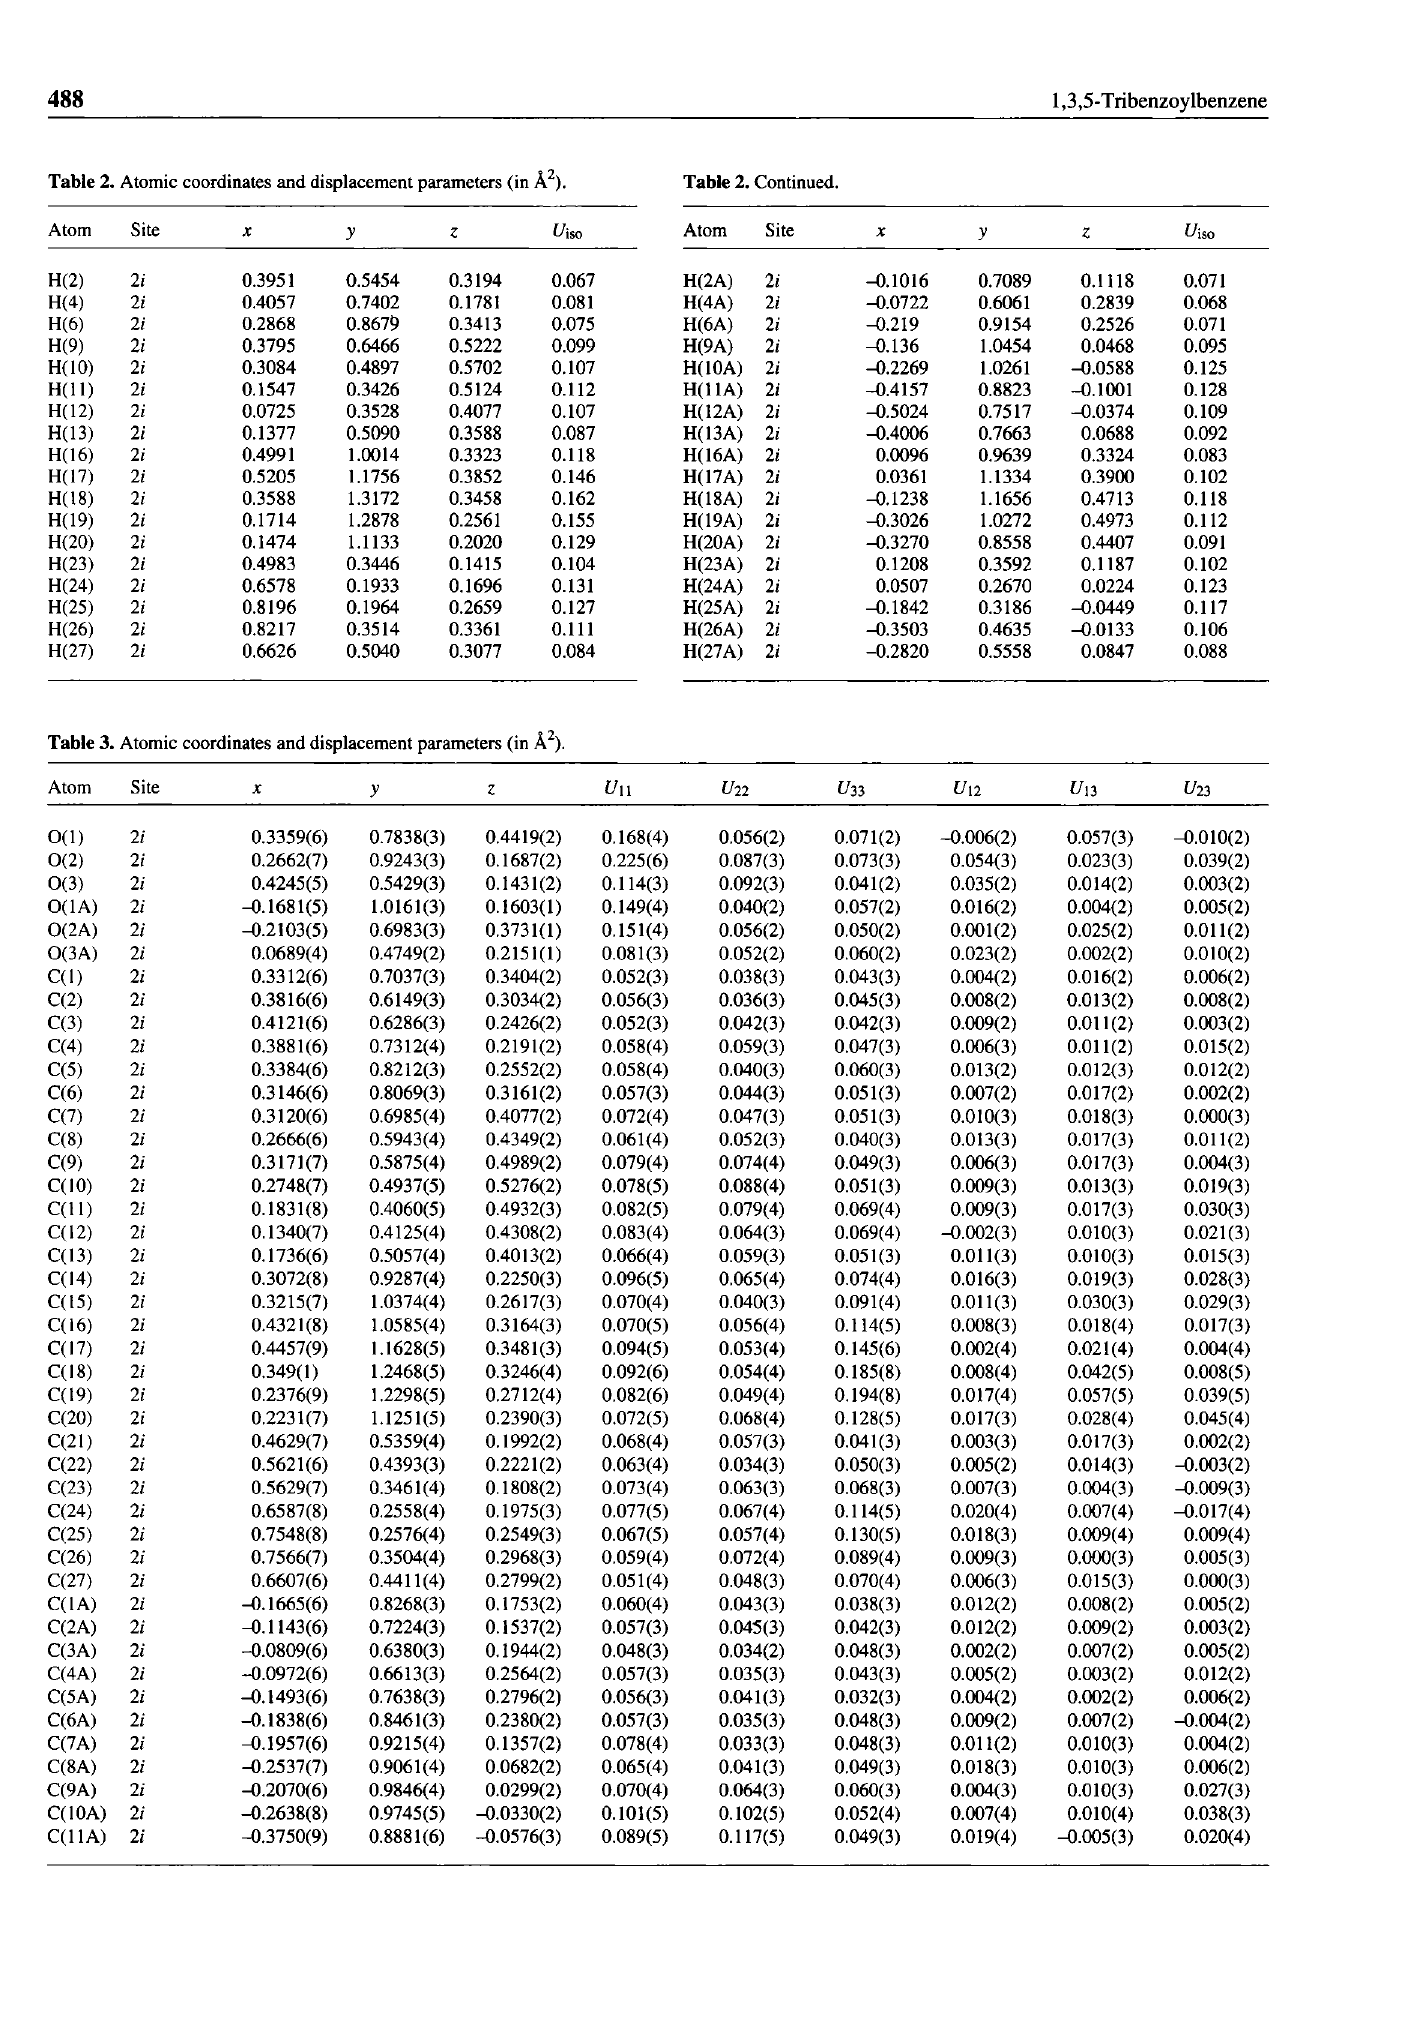
Table 2. Atomic coordinates and displacement parameters (in Ä 2 ).